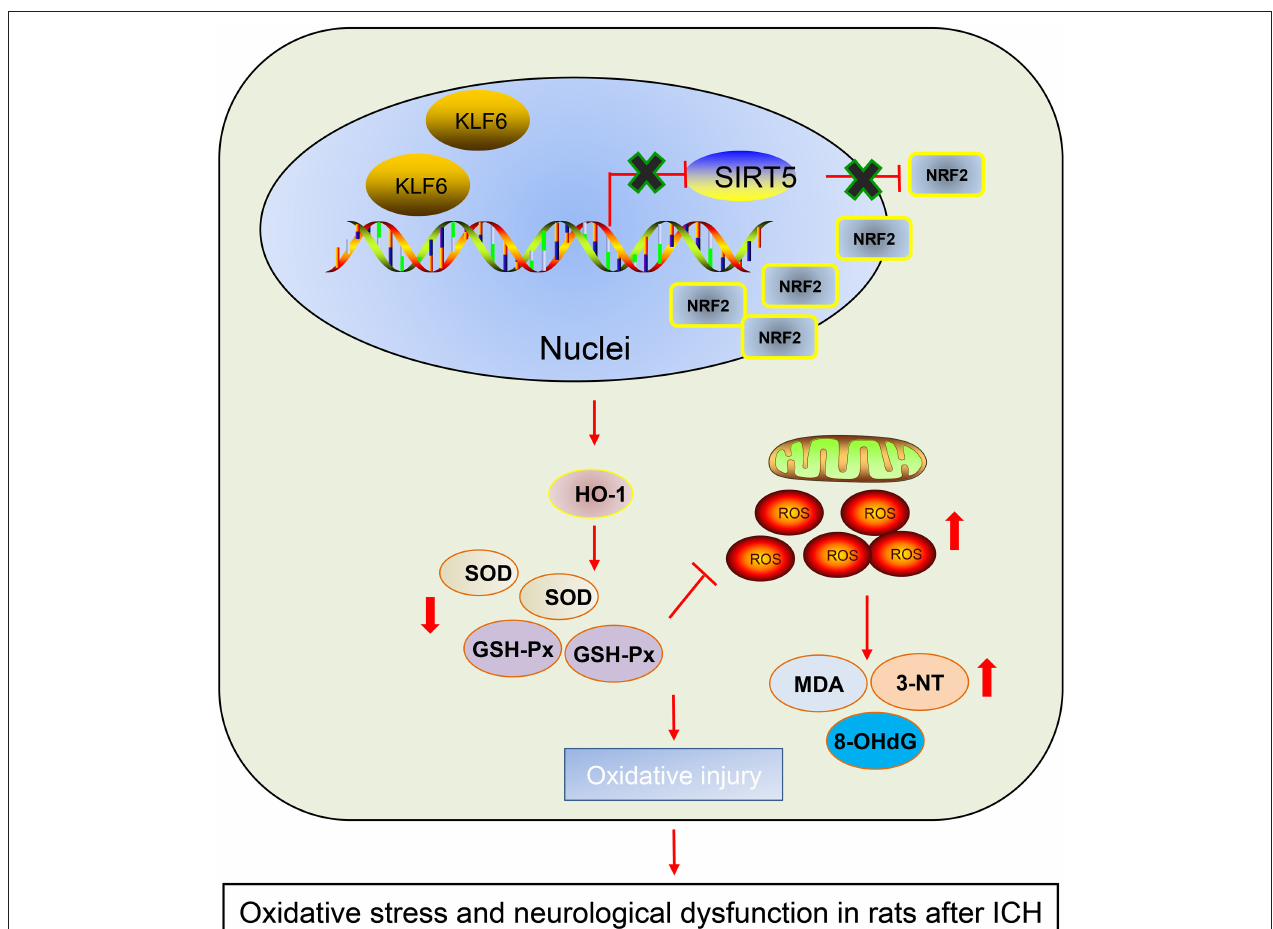
FIGURE 10 | The graphical summary of the function and mechanism of KLF6 in ICH. Nuclear transcription factor KLF6 mediates SIRT5/Nrf2/HO-1 axis to regulate brain tissue damage and oxidative stress in ICH rats. Nuclear transcription factor KLF6 is highly expressed in ICH rats. KLF6 transcriptionally inhibits SIRT5 and then activates the Nrf2/HO-1 signaling pathway, thus repressing mitochondrial membrane potential and promoting hippocampal ROS and apoptosis in neurons, which ultimately accelerates oxidative stress and neurological dysfunction in rats after